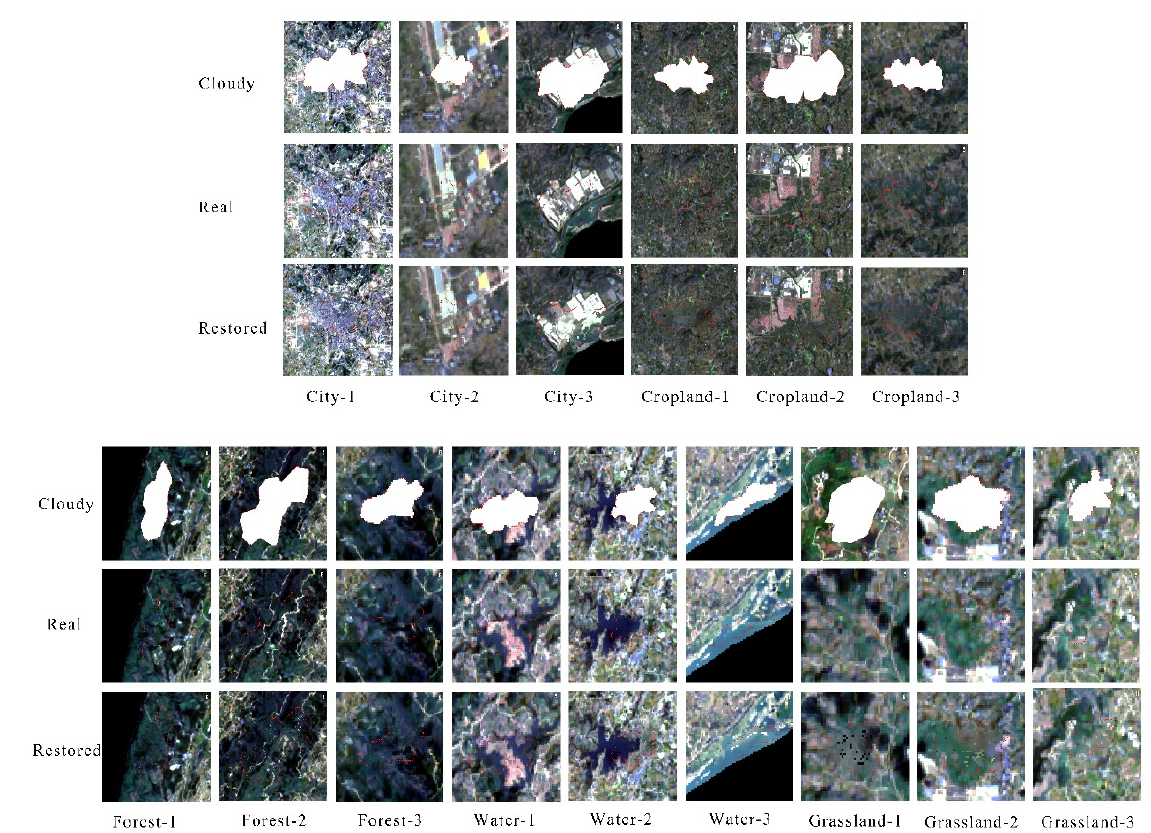
Figure 7. The red–green–blue composite images of Landsat 8 OLI image that were acquired on 2 May 2020. Three plots were selected for each land type. The cloud images in the first row are cloudy images simulated based on the real images in the second row. The third row is images recovered by the MNSPI approach. The white area represents the simulated thick cloud patch, and the red line is the cloud patch boundary.